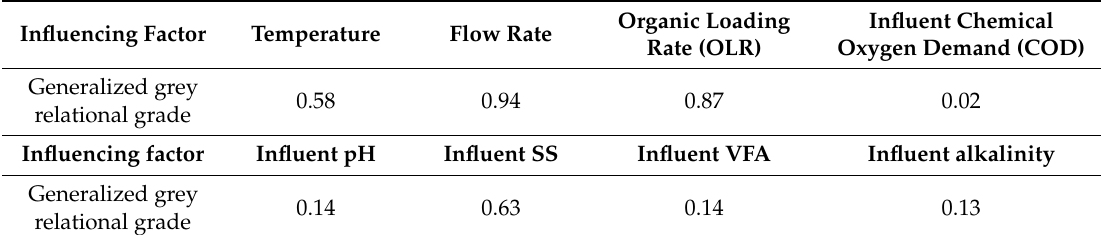
Table 3. Generalized Grey Relational Grade of Respective Factors on Chemical Oxygen Demand (COD) Removal Effectiveness.